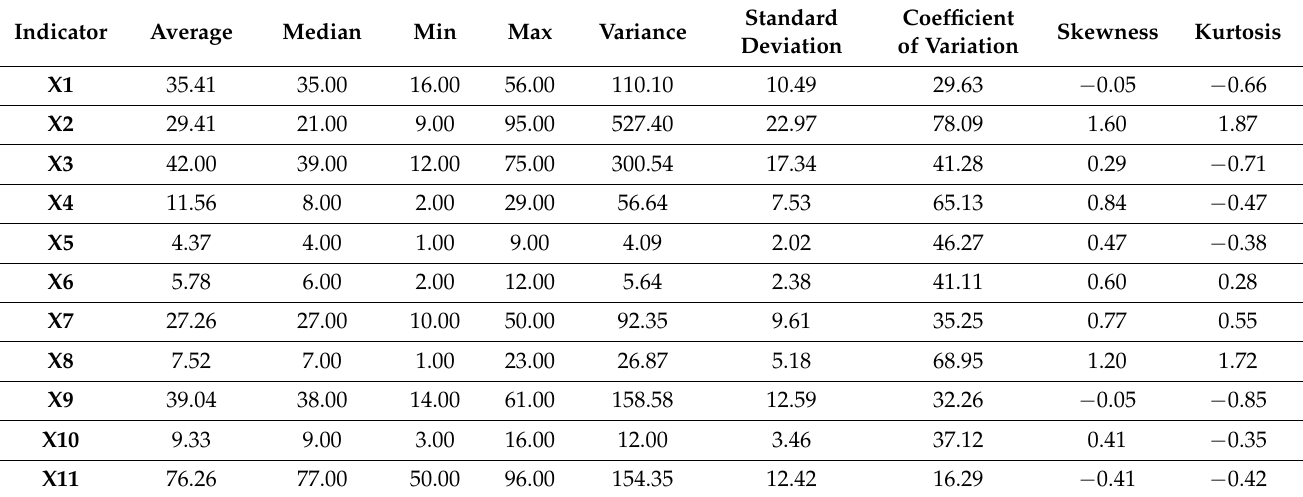
Table 3. Basic static parameters of studied